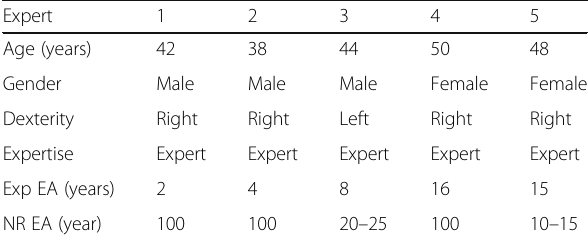
Table 1 Demographic data and experience of the